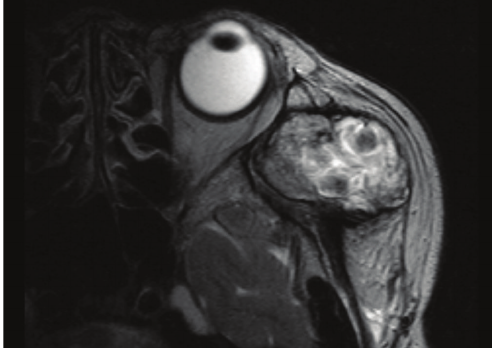
Figure 2: Preoperative MRI on T2-weighted image showing high signal intensity admixed with irregular low signal areas in left temporal fossa.